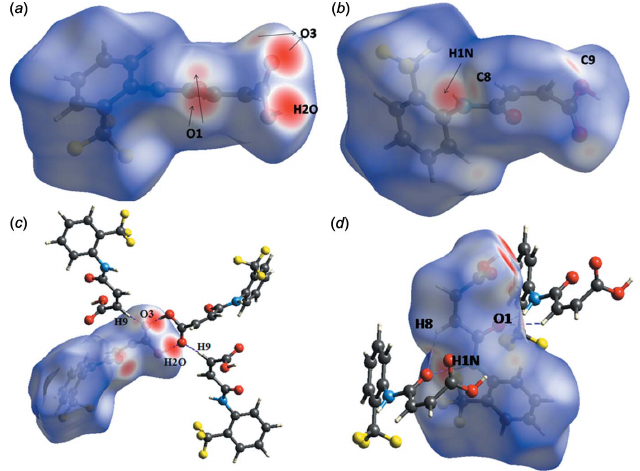
Figure 3 The Hirshfeld surface mapped with d norm for the molecule in (I) over the range (cid:6) 0.753 to 1.252 a.u., shown interacting with near-neighbour molecules connected through hydrogen bonds (dashed lines). (cid:4) 2.4 A˚ ), C (cid:3) (cid:3) (cid:3) H/H (cid:3) (cid:3) (cid:3) C (13.2%; d